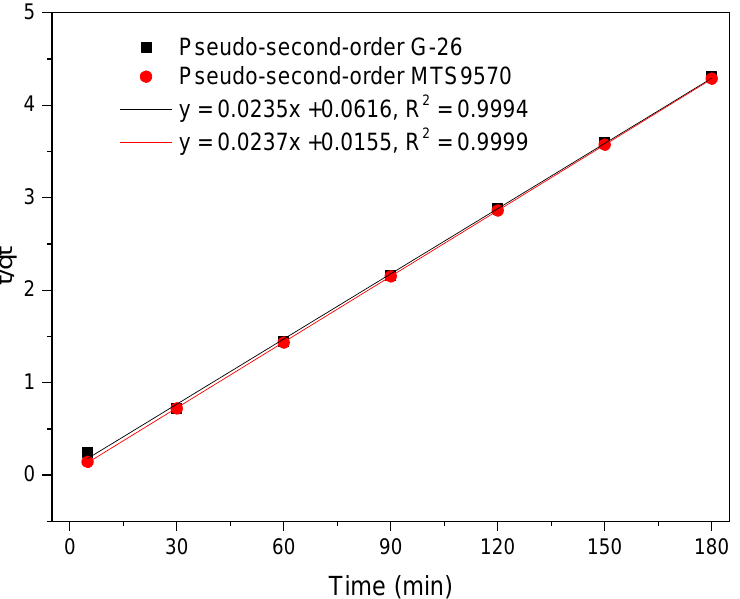
Figure 12. Pseudo-second-order modelling for adsorption of Pb(II) onto G-26 and MTS9570 resins. Table 4. Kinetic parameters for the adsorption of Pb(II) ions onto G-26 and MTS9570.